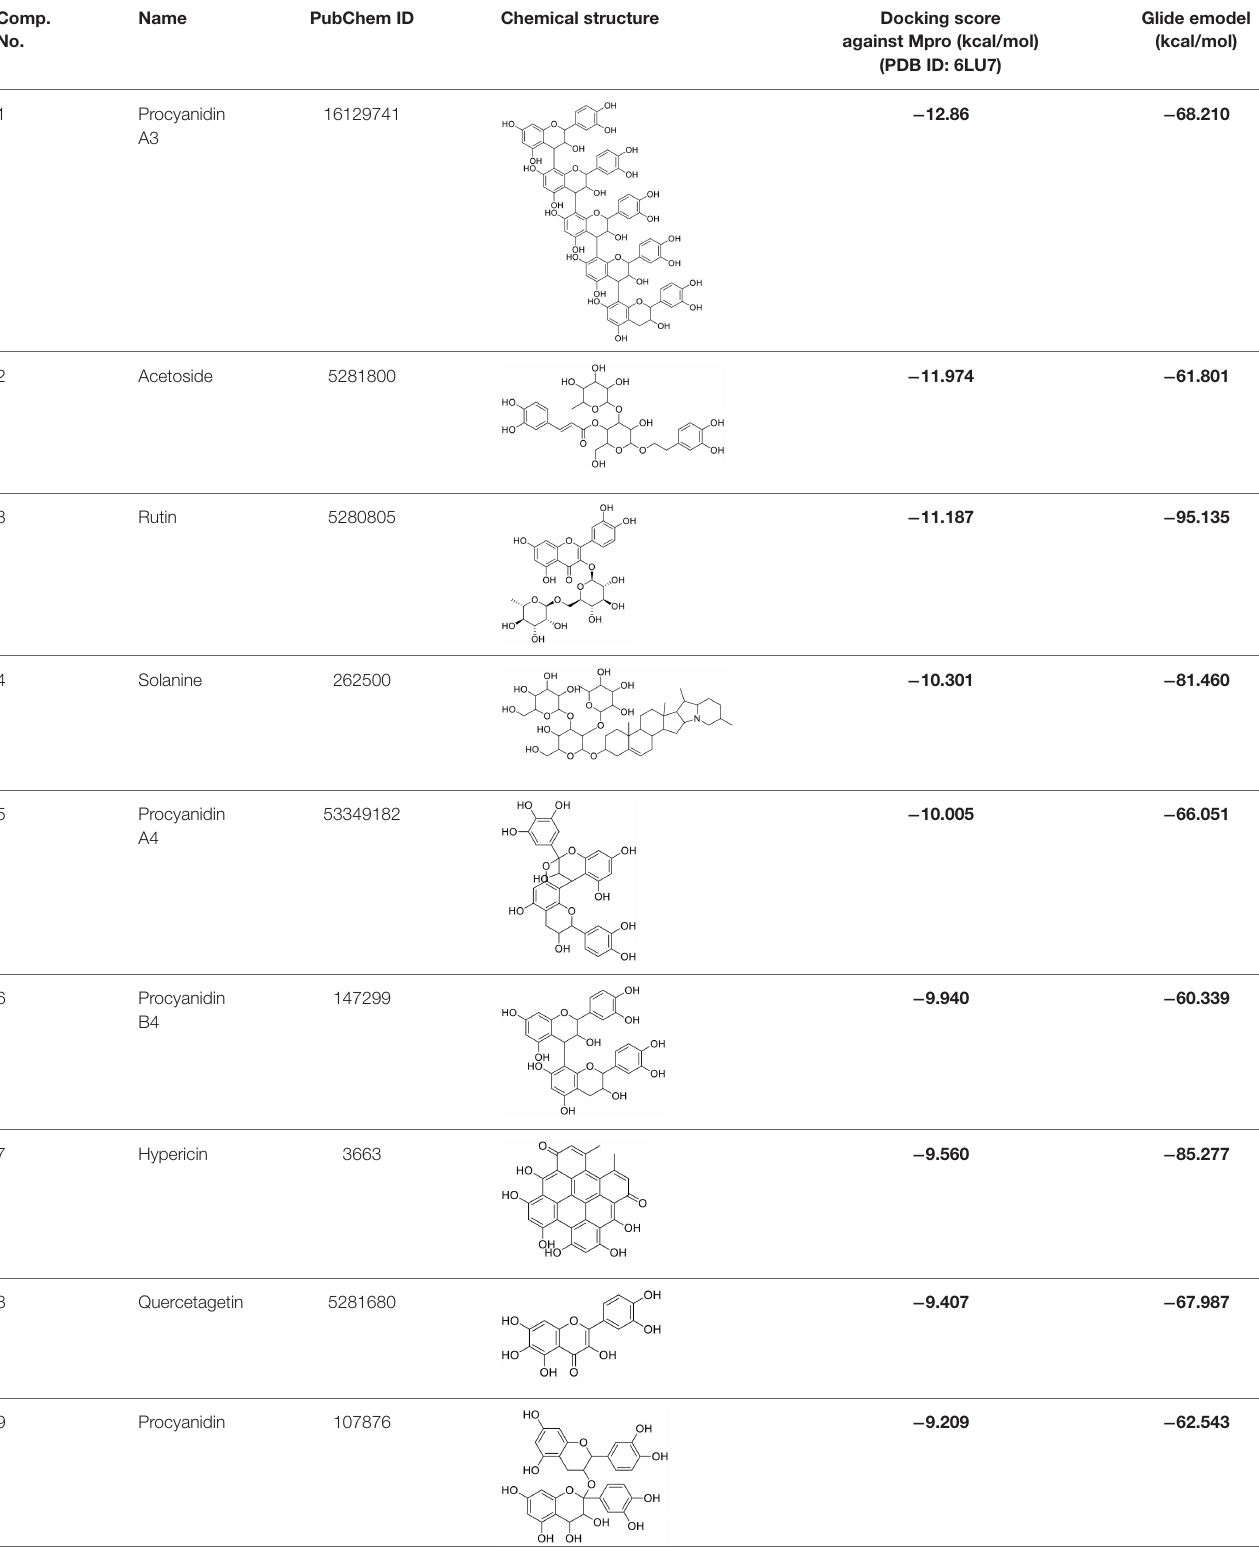
TABLE 1 | Chemical structures and docking results of phytoconstituents on Mpro of SARS-CoV-2. Comp.